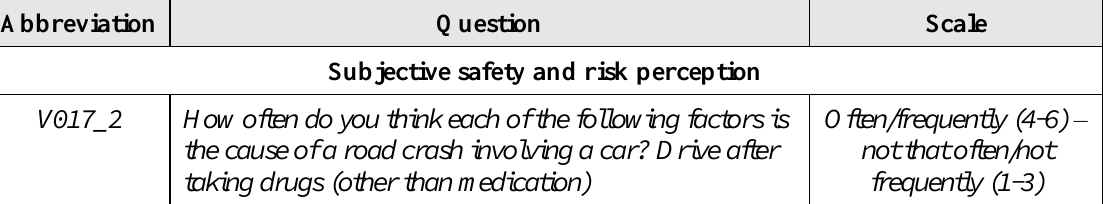
Table 1 ( cont. ). Considered variables from the ESRA2 questionnaire.